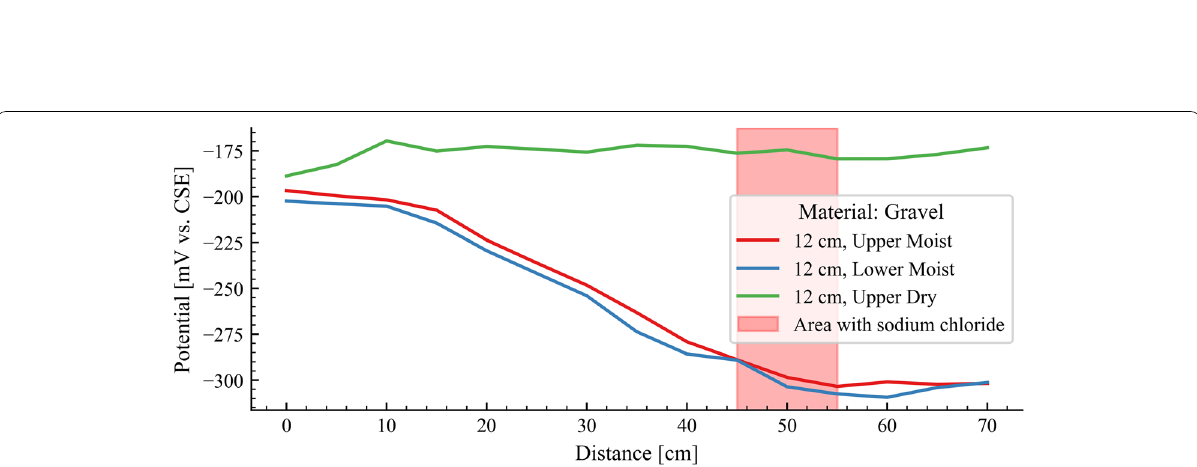
Fig. 12 Comparison of the potential measurement results in dry and moist in dependence on the distance between the electrode and the reinforcement made of steel for the upper and lower row of holes in the wooden frame (Fig. 11) where the red rectangle marks the location treated with sodium